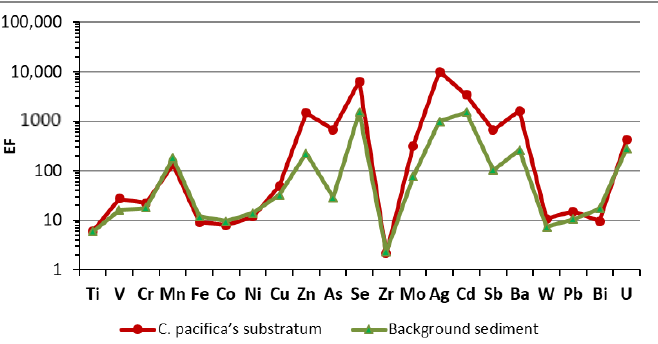
Figure 11. Distribution of Enrichment Factor (EF) in the C. pacifica settlement’ substratum and background sediments from the Piip Volcano’s southern top.